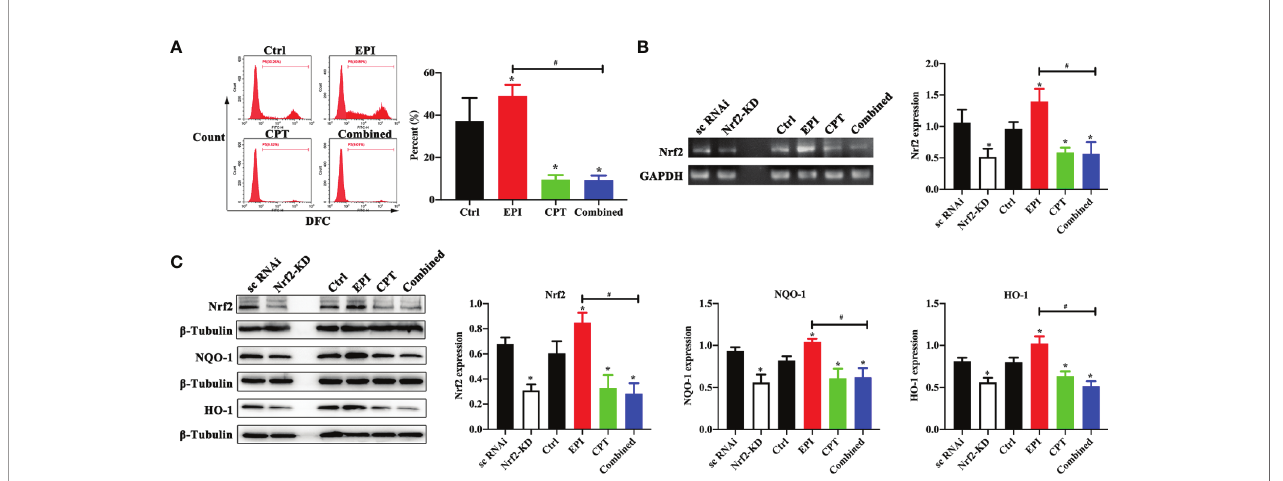
FIGURE 1 | Expression of ROS level and Nrf2 expression with EPI and CPT administration in Huh7 cells. The non-transfected Huh7 cells were treated with EPI and CPT for 48 h. The sc RNAi and Nrf2-KD were transfected with scramble negative control and Nrf2-knockdown RNAi. (A) ROS level detected by fl ow cytometry after EPI and CPT intervention in Huh7 cells. (B) The mRNA expression and assay of Nrf2 by western blot in Huh7 cells. (C) The protein expression of Nrf2, NQO-1, and HO-1 in Huh7 cells. *P < 0.05, # P <